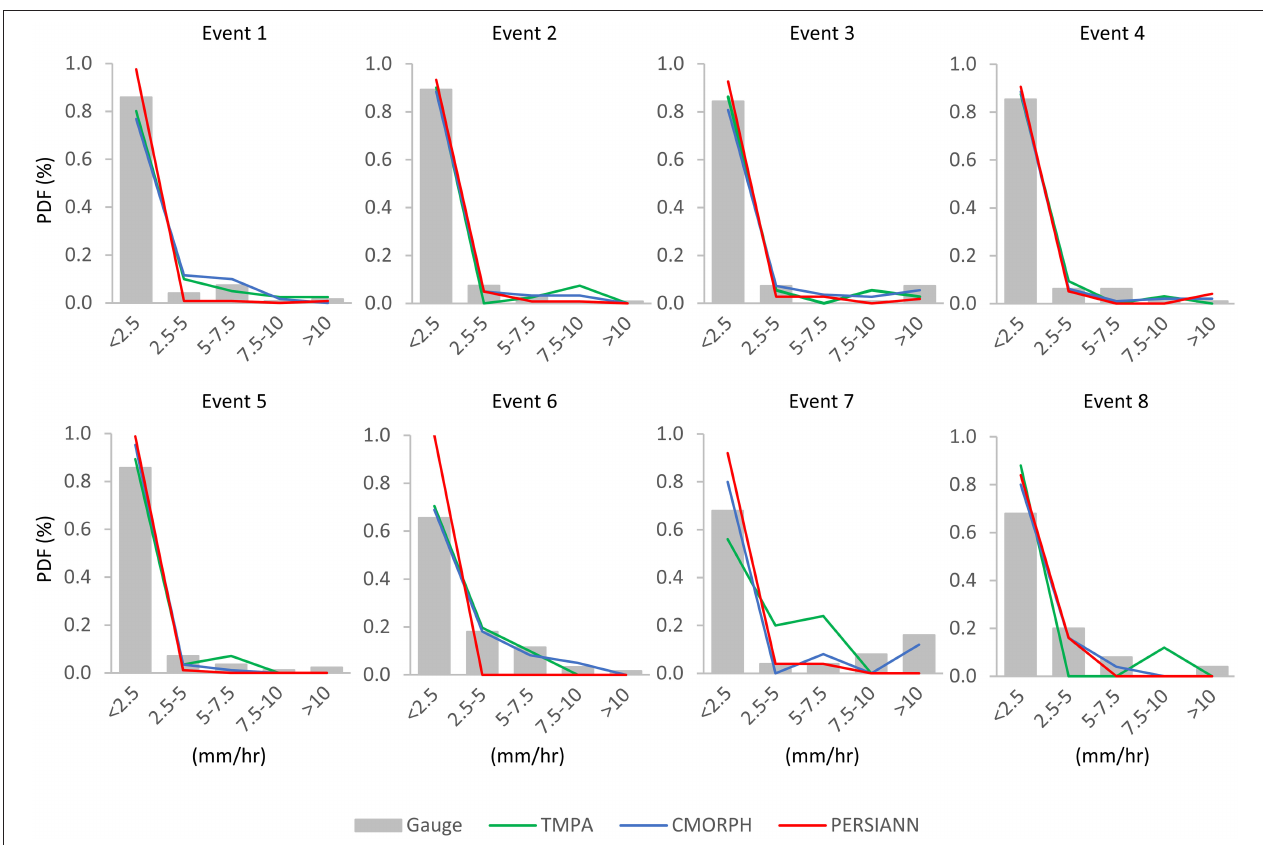
FIGURE 4 | Probability Density Functions of events as a function of hourly intensity (mm/h) recorded at rain gauge EVGR, and by TMPA, CMORPH, and PERSIANN at gauge location EVGR during the eight hydrometeorological extreme events.